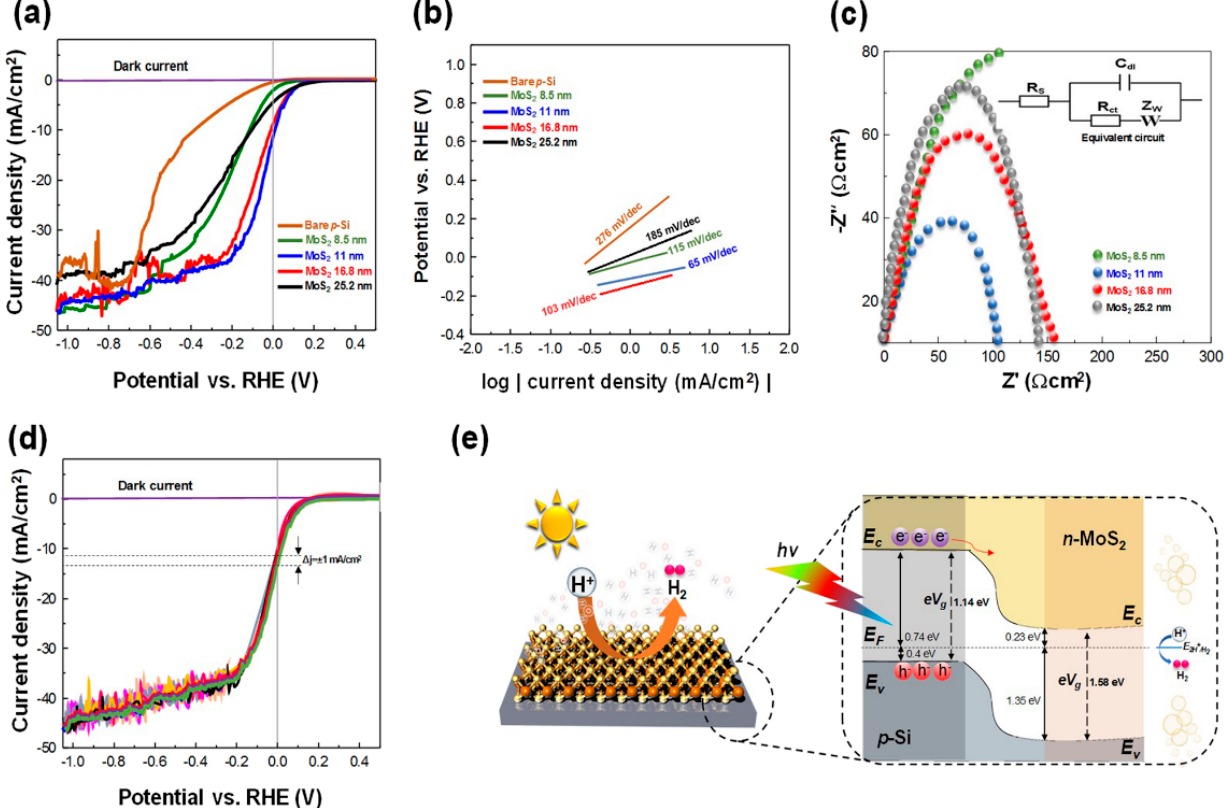
Figure 3. Properties of MoS 2 /p-Si junction. ( a ) Photoelectrochemical evaluation of the polarization J-V curves. ( b ) Tafel slopes. ( c ) EIS measurements. ( d ) Stability test over 20 cycles for 11 nm MoS 2 thickness. ( e ) Energy band diagram of 11 nm MoS 2 thickness. Reproduced from [70]. NPG Asia Materials 2019.